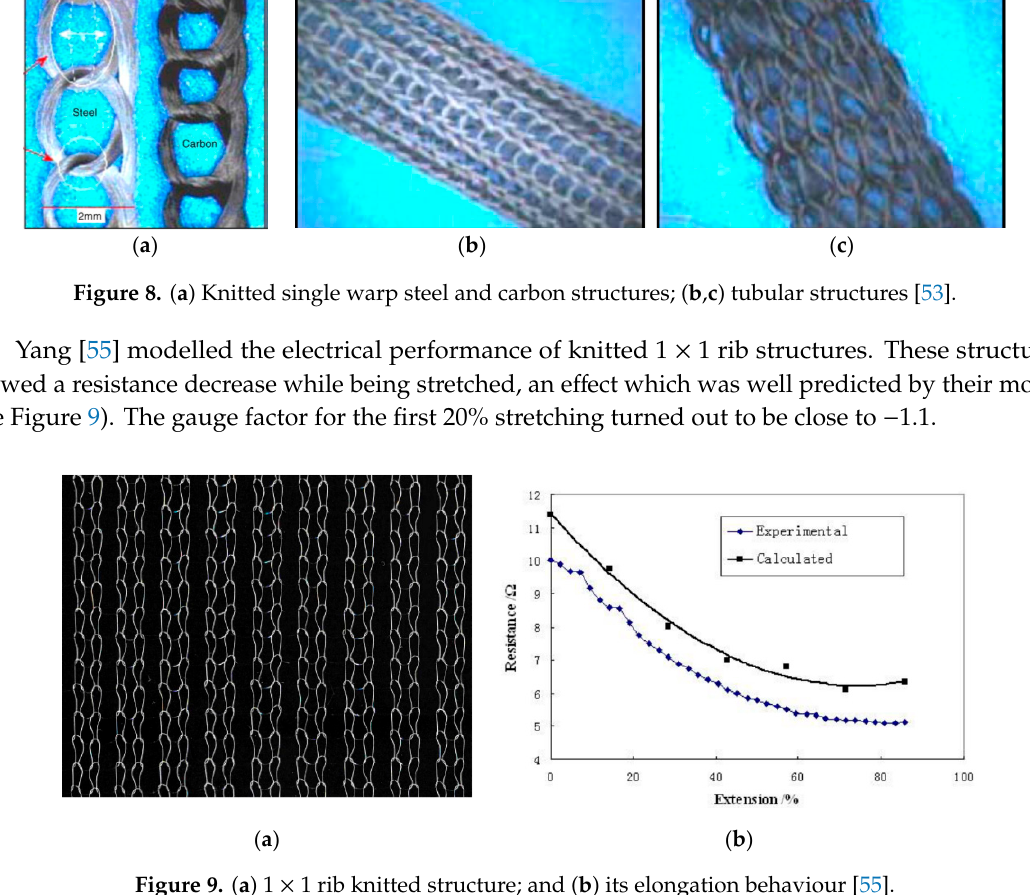
Figure 9. ( a ) 1 × 1 rib knitted structure; and ( b ) its elongation behaviour [55] .